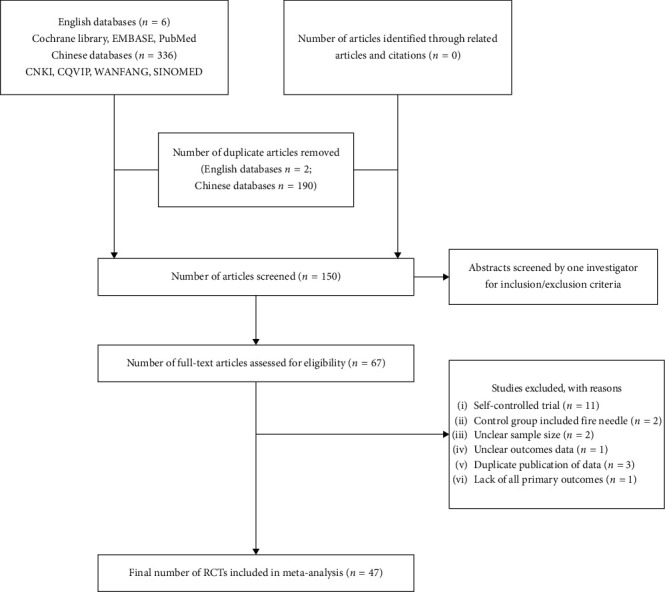
Flowchart of study selection. RCT, randomized controlled trial; EMBASE, Excerpta Medica dataBASE.